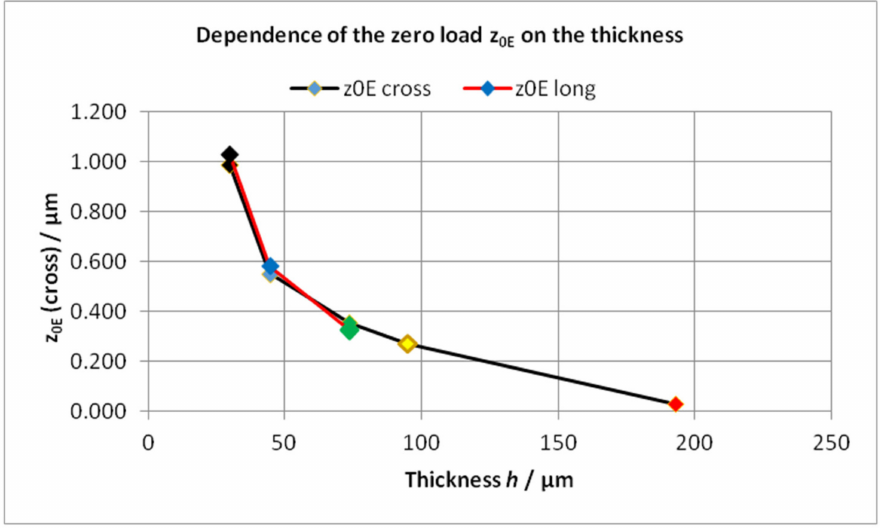
Figure 15. The dependence of the zero load z 0 E on the thickness measured in the direction “cross”, (black line, values bow corrected, Table 5) and “long” (red line, single-end leveled and bow corrected). The values for the thicknesses h = 30 µ m are mean values of 4 cantilevers.